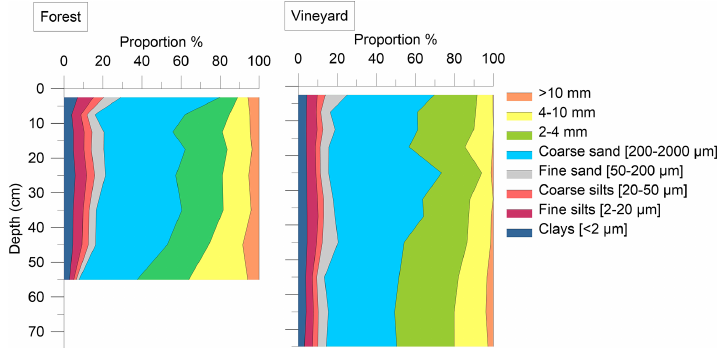
Figure B1. Soil particle size distribution of the pit samples under the forest and under the vineyard, as a function of depth. The eight particle size fractions are clay < 2µm (dark blue), fine silt 2–20µm (burgundy), coarse silt 20–50µm (pink), fine sand 50–200µm (gray), coarse sand 200–2000µm (sky blue), 2–4mm (green), 4–10mm (yellow), and > 10mm (orange). The different fractions are expressed in percent of the mineral phase. The particle size profiles in the forest and vineyard soils showed about 50% coarse sand and did not vary significantly with depth. There was no significant difference in soil particle size distribution between the forest and vineyard plots.